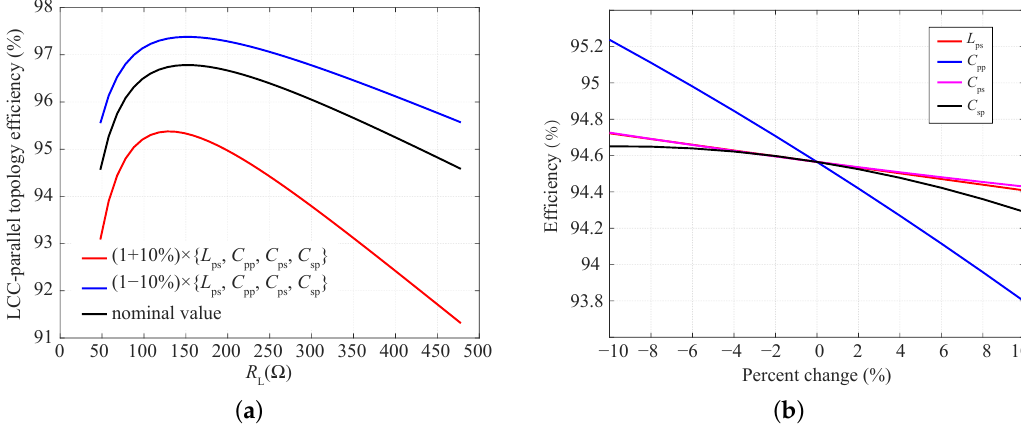
Figure 8. ( a ) Effect of the parameter variation from the nominal value on the system efficiency and ( b ) system efficiency in respect to the percent changes of all compensation